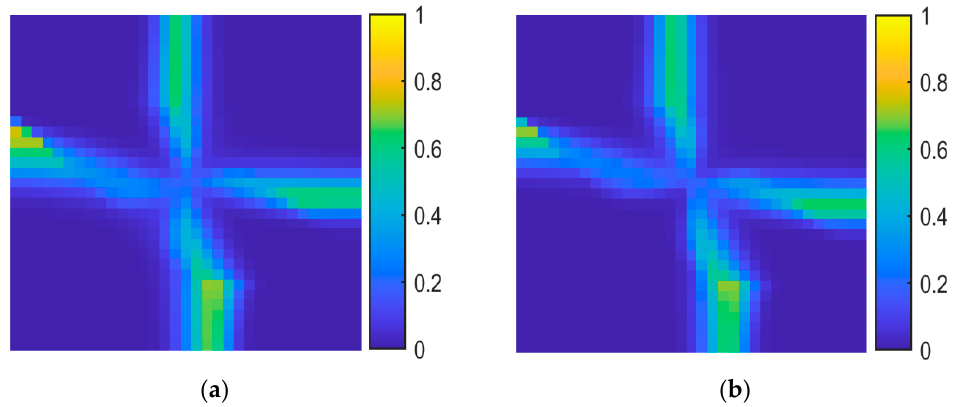
Figure 19. Remaining oil distribution before and after flow-field adjustment in the single-layer syn- thetic model with a block-like permeability strip. ( a ) Before adjustment; ( b ) after adjustment.